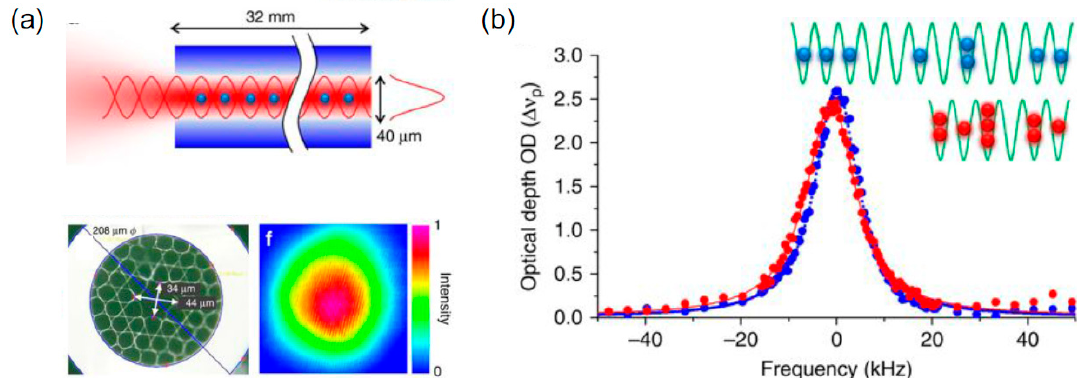
Figure 29. ( a ) Atoms in the HCPCF radially- and axially-confined by the optical lattice, preventing atoms from interacting with the fiber-wall (top). Microscope image of the Kagome fiber and Far-field pattern of the laser intensity passed through a 32-mm-long HCPCF (bottom). ( b ) Absorption spectra with and without atomic expansion over lattice sites, as illustrated in the inset, are displayed by blue and red symbols, respectively, corresponding to a mean atom occupation of m = 0.45 and m = 1.7. (Reprinted and adapted with permission from Reference [29], Nature, 2014.)